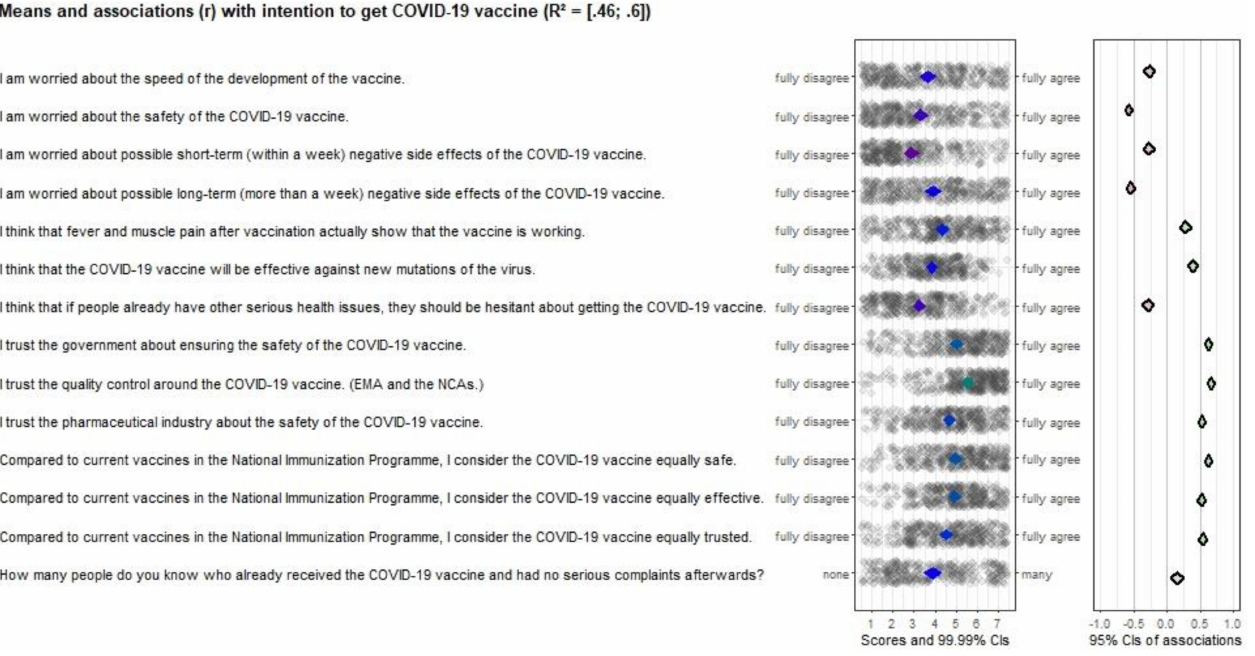
Figure 1. CIBER plot of concerns and trust visualizing means and association with intention to get the COVID-19